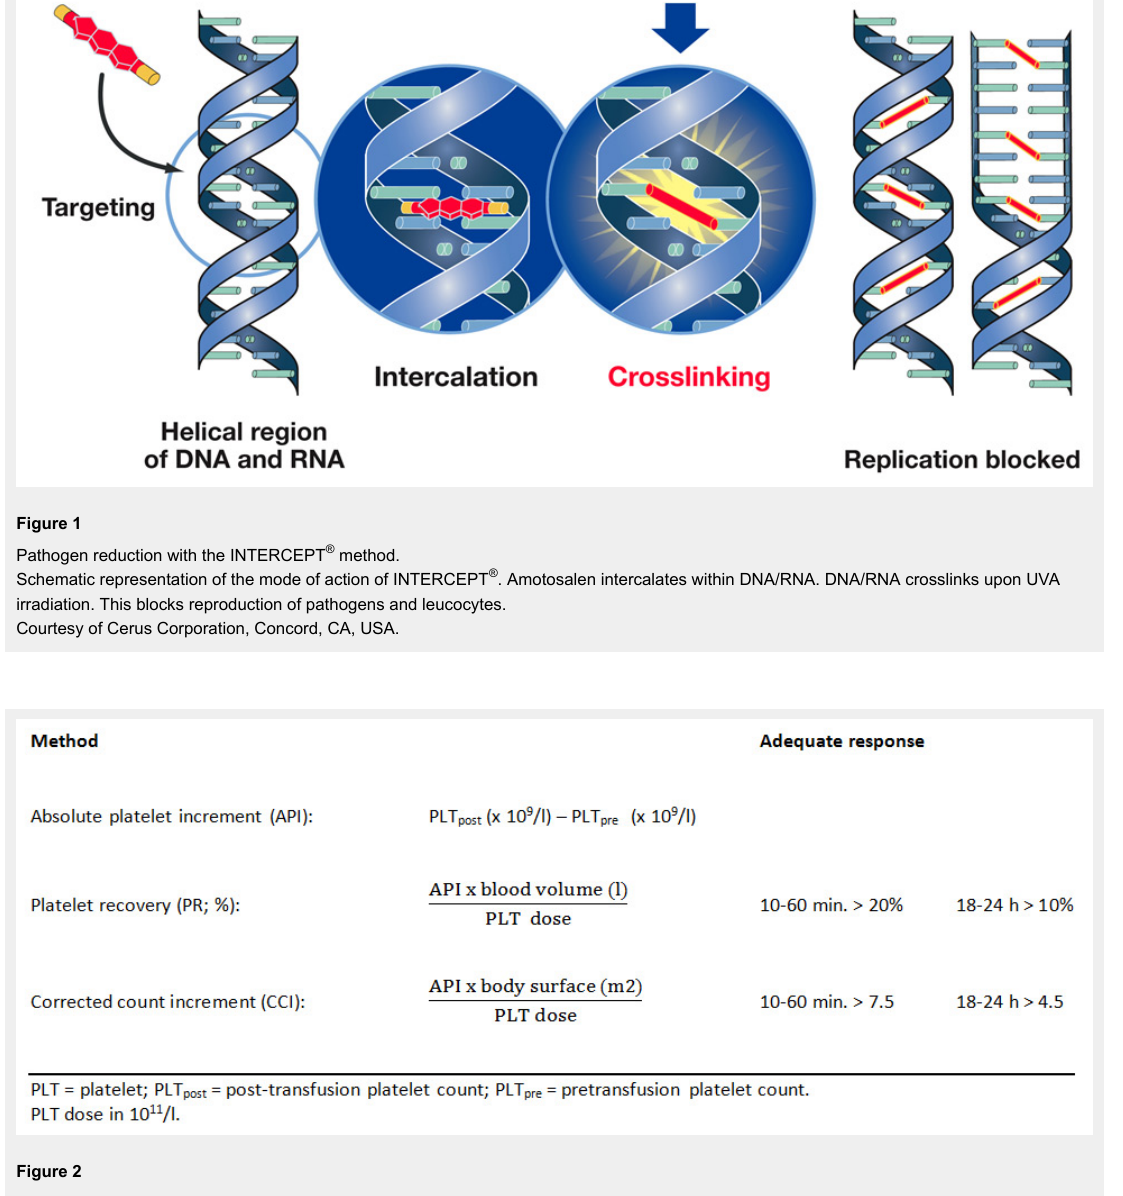
Methods for assessment of platelet transfusion